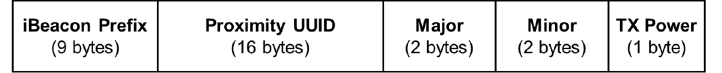
Figure 4. Apple iBeacon message format.